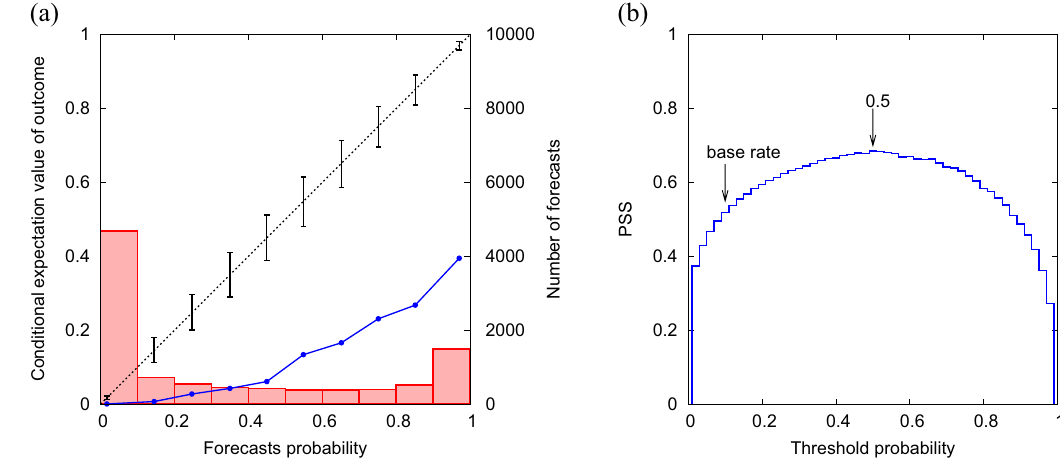
Fig. 2. Same as Figure 1, but for case 2. (a) Reliability diagram for case 2. (b) PSS versus threshold probability for case